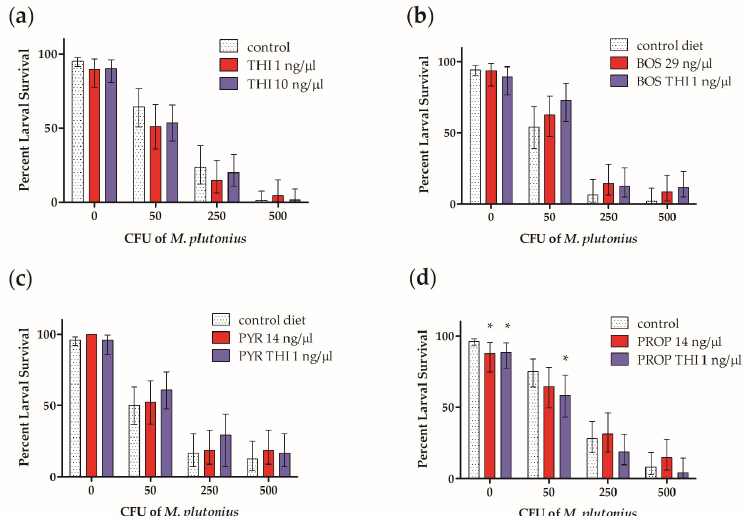
Figure 2. Effects of chronic pesticide exposure on larval survival from European foulbrood. ( a ) Percentage survival of larvae fed control diet or diet with thiamethoxam (THI; 1 or 10 ng / µ L); ( b ) Percentage survival of larvae fed control diet, diet with boscalid (BOS; 29 ng / µ L), or diet with BOS and THI (1 ng / µ L); ( c ) Percent survival of larvae fed control diet, diet with pyrimethanil (PYR; 14 ng / µ L), or diet with PYR and THI (1 ng / µ L); ( d ) Percentage survival of larvae fed control diet, diet with propiconazole (PROP; 14 ng / µ L), or diet with PROP and THI (1 ng / µ L). Bars show percent larval survival at day 6 with 95% confidence interval for 45–84 worker honeybee larvae reared in vitro and infected with 0, 50, 250, or 500 colony forming units (CFU) of Melissococcus plutonius and 191–300 survival control larvae, which were unexposed to pesticides and not infected with M. plutonius . Percentage larval survival was analyzed with a Chi-squared test. * indicates significant difference ( p < 0.05) relative to control for each inoculum (CFU) of M. plutonius . Larval survival from European foulbrood was significantly decreased by co-exposure to the insecticide thiamethoxam with the fungicide